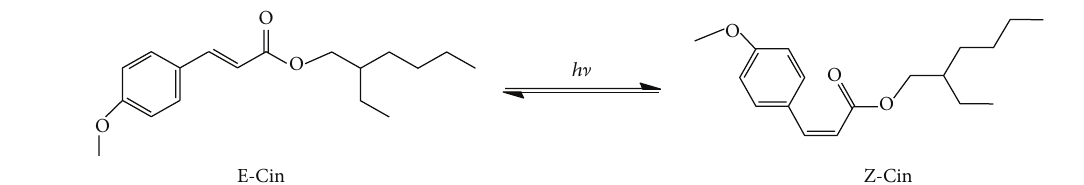
Figure 4: Chemical structure of E- and Z-Cin configuration.